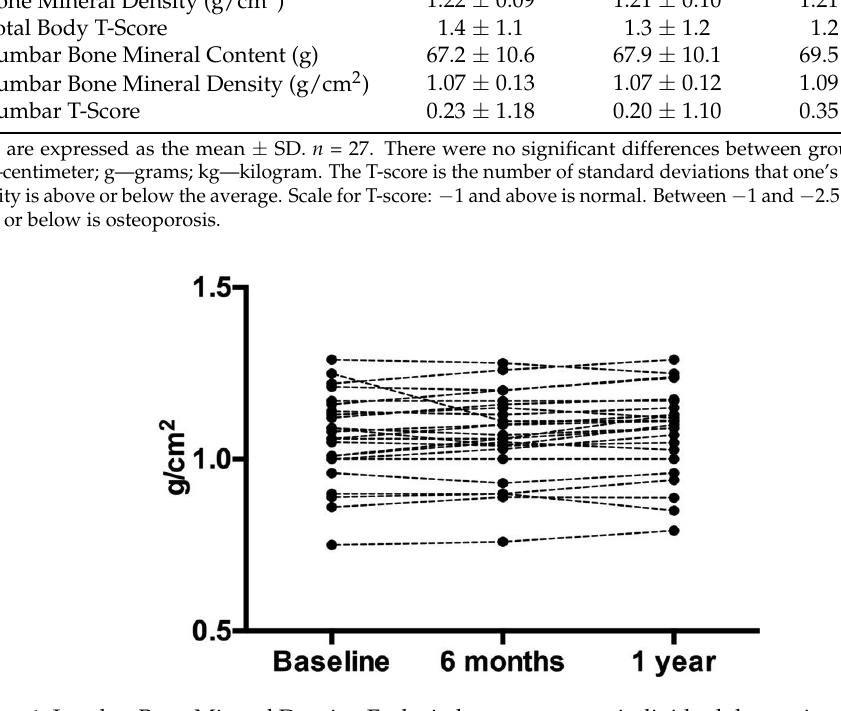
Figure 1. Lumbar Bone Mineral Density. Each circle represents an individual data point. Despite the slight variation in individual data, the overall group mean did not change.